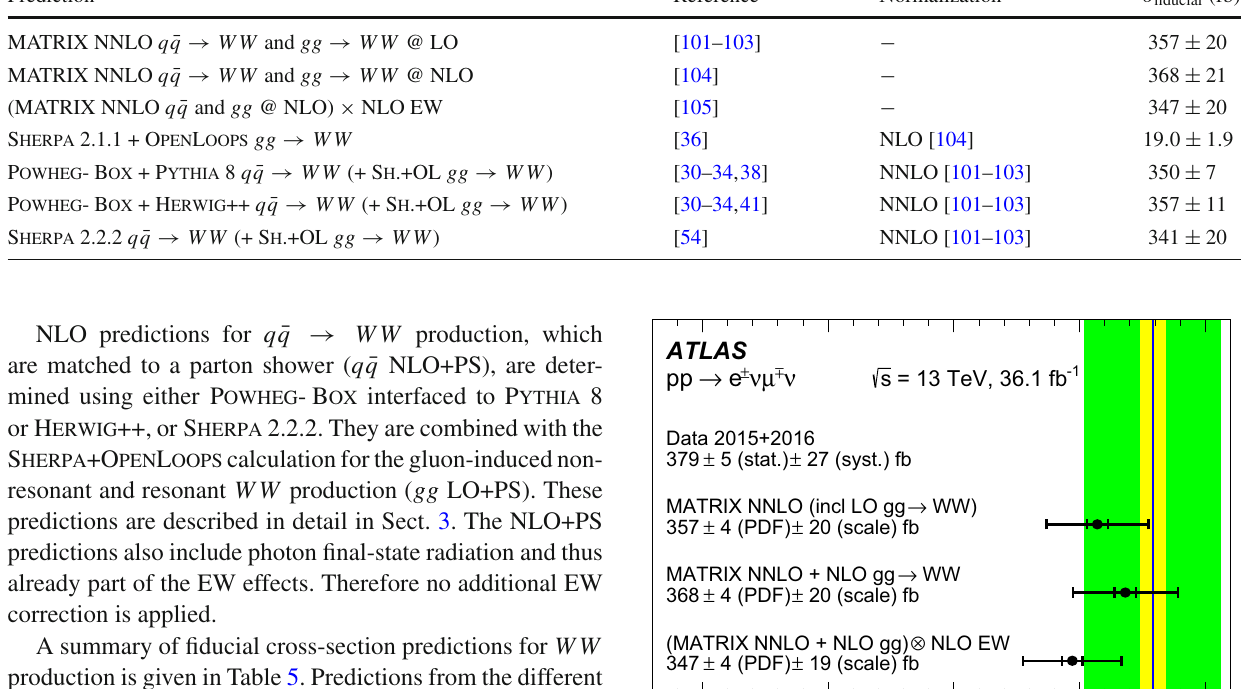
Table 5 Predictions of the WW fiducial cross-section. Predictions matched to parton showers are normalized to inclusive fixed-order calculations Prediction Reference